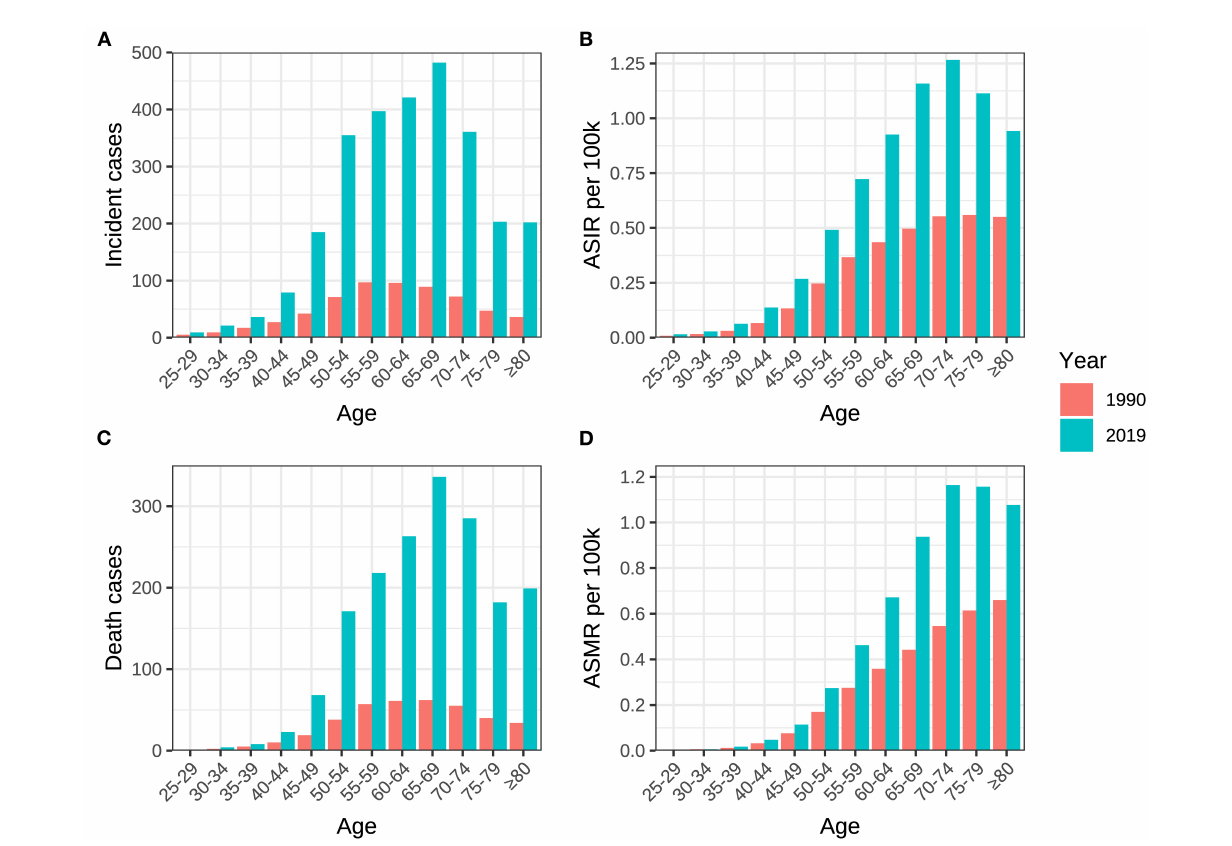
FIGURE6 Age distribution of incidence, death, ASIR and ASMR of ovarian cancer attributable to hyperglycemia in China between 1990 and 2019. (A) Incident cases, (B) ASIR, (C) death cases, and (D) ASMR.